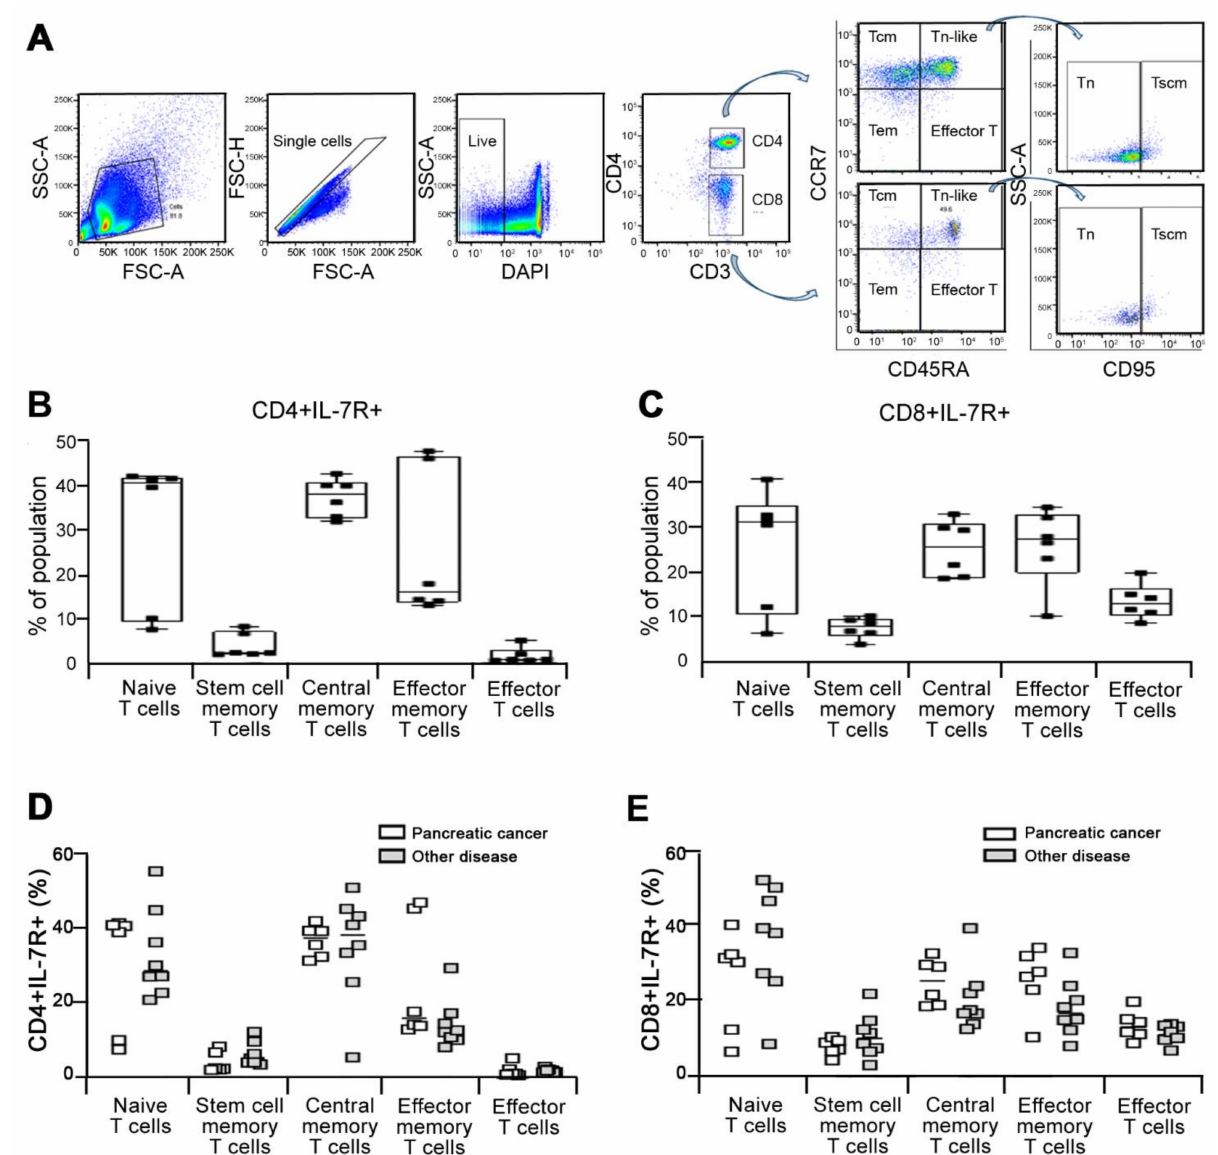
Figure 4. Characterization of IL-7R α expressing cells in T lymphocytes. ( A ) Representative gating strategy for identification of IL-7Ra expressing cells in T lymphocytes based on expression of cell markers including CD3, CD4, CD45RA, CCR7, and CD95 to define naive (CD45RA+CCR7+CD95-), stem cell-like memory (Tscm, CD45RA+CCR7+CD95+), central memory (Tcm, CD45RA-CCR7+), effector memory (Tem, CD45RA-CCR7-) and effector T cells (CD45RA+CCR7-) among CD4+CD3+ T cells. ( B , C ) PBMC were isolated from pancreatic cancer patients ( n = 6). The abundance of IL-7R+ cells were evaluated in naive, stem cell-like memory, central memory, effector memory, and effector T cells among CD4+CD3+ T ( B ) and CD8+CD3+ T ( C ) cells in PBMC isolated from patients with pancreatic cancer ( n = 6) and other disease ( n = 8) including acute pancreatitis ( n = 1), pancreatic cysts ( n = 1), chronic pancreatitis ( n = 1), bile duct cancer ( n = 3), lung cancer ( n = 1), and cholangiocellular carcinoma ( n = 1) by flow cytometry analysis. ( D , E ) The percentage of IL-7R+ cells was determined in these cells among CD4+CD3+ T ( D ) and CD8+CD3+ T ( E ) cells from ( B , C